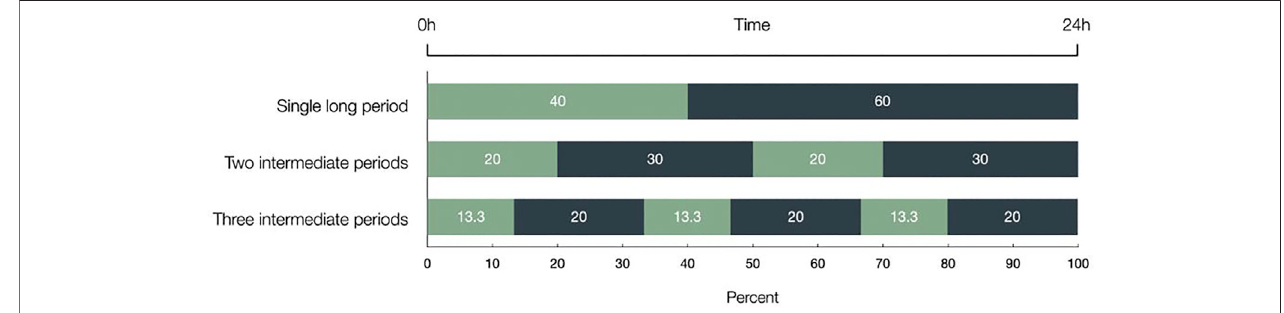
FIGURE 1 | The three different distributions of the 40%T > MIC within 24 h are depicted and given in percentage. Light bars represent the time meropenem was present and dark bars represent antibiotic free time. The 40%T > MIC has been achieved in one single long period, in two intermediate periods (2 × 20%), and in three intermediate periods (3 × 13.3%), thereby keeping the overall period of T > MIC constant. Time over Minimal Inhibitory Concentration (T >